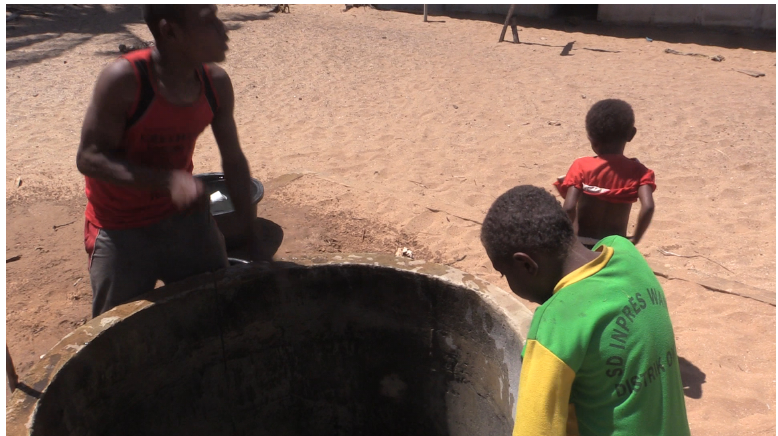
Figure 3: ‘No, wait! There’s a little fish swimming around inside.’; cf. example